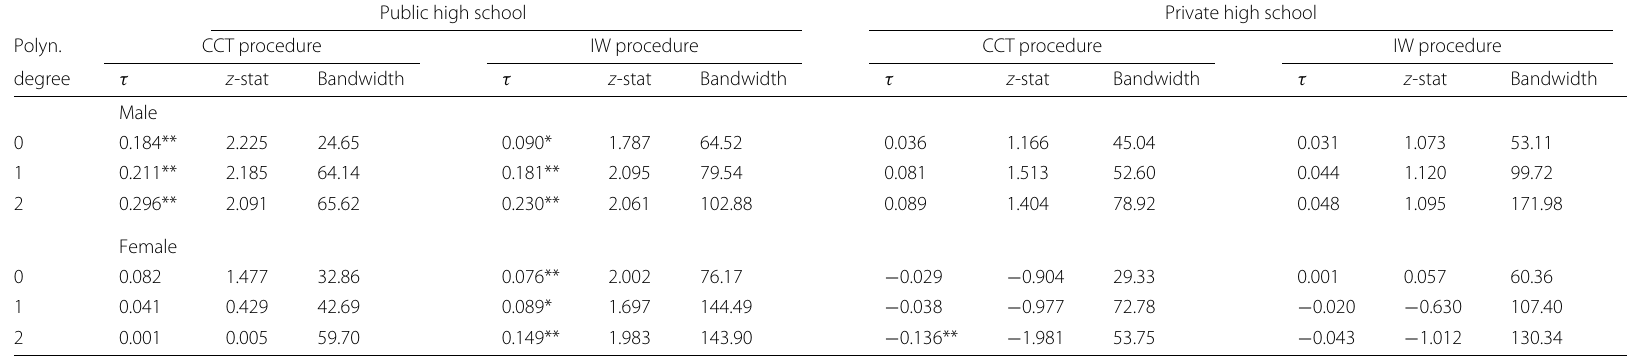
Table 7 RD estimates of test scores by school choice